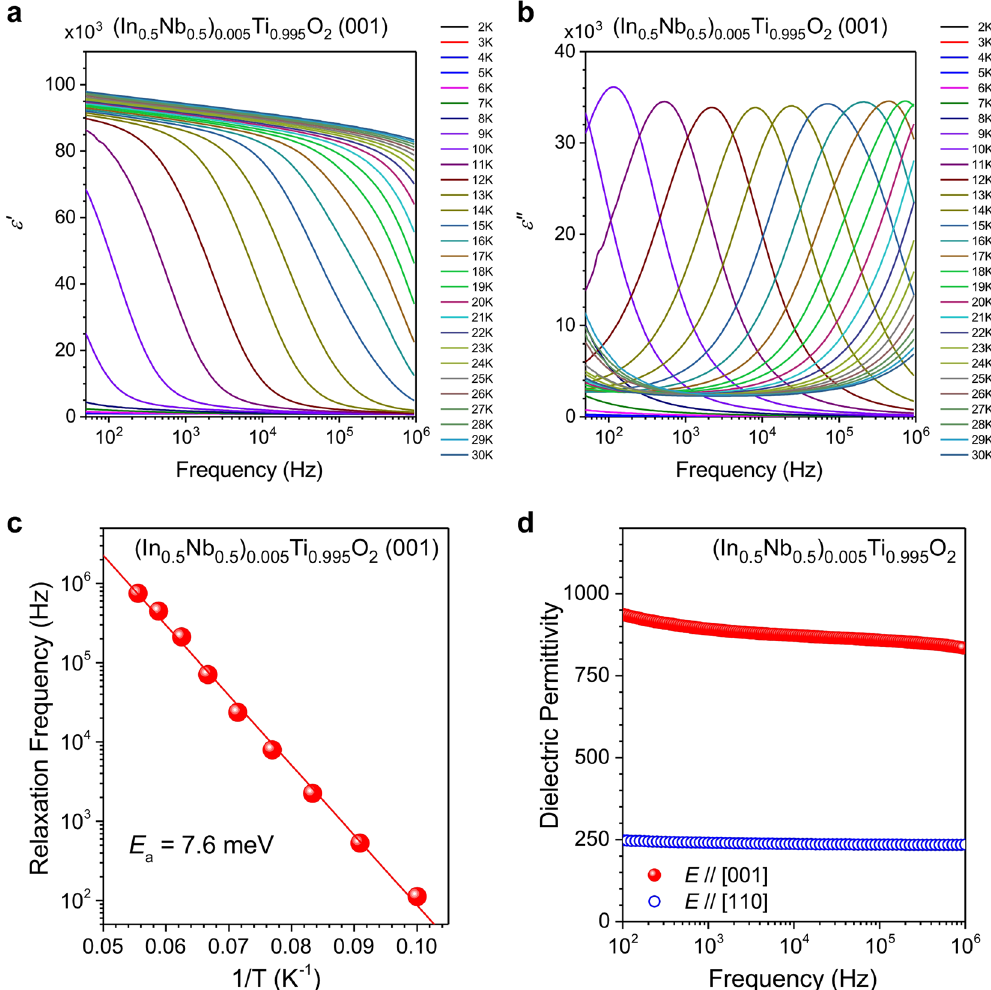
Figure 2. Frequency dispersions for ( a ) the real and ( b ) imaginary parts of the dielectric permittivity of a NITO-0.5% single crystal with a (001) wide surface measured at several temperatures ranging from 2 K to 30 K. Panel (c) shows an Arrhenius plot for the relaxation frequency against the inverse temperature. The activation energy of 7.6 meV for the thermally excited carriers was estimated from linear fitting and is shown by the solid line. Panel (d) shows the frequency dispersions for the dielectric permittivity in NITO-0.5% at 4 K measured along the [001] and the [110] directions, which are represented by closed and open circles,